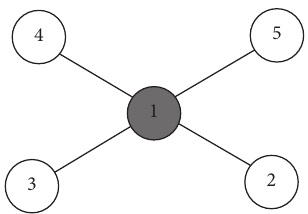
Figure 5: A network with five nodes and four